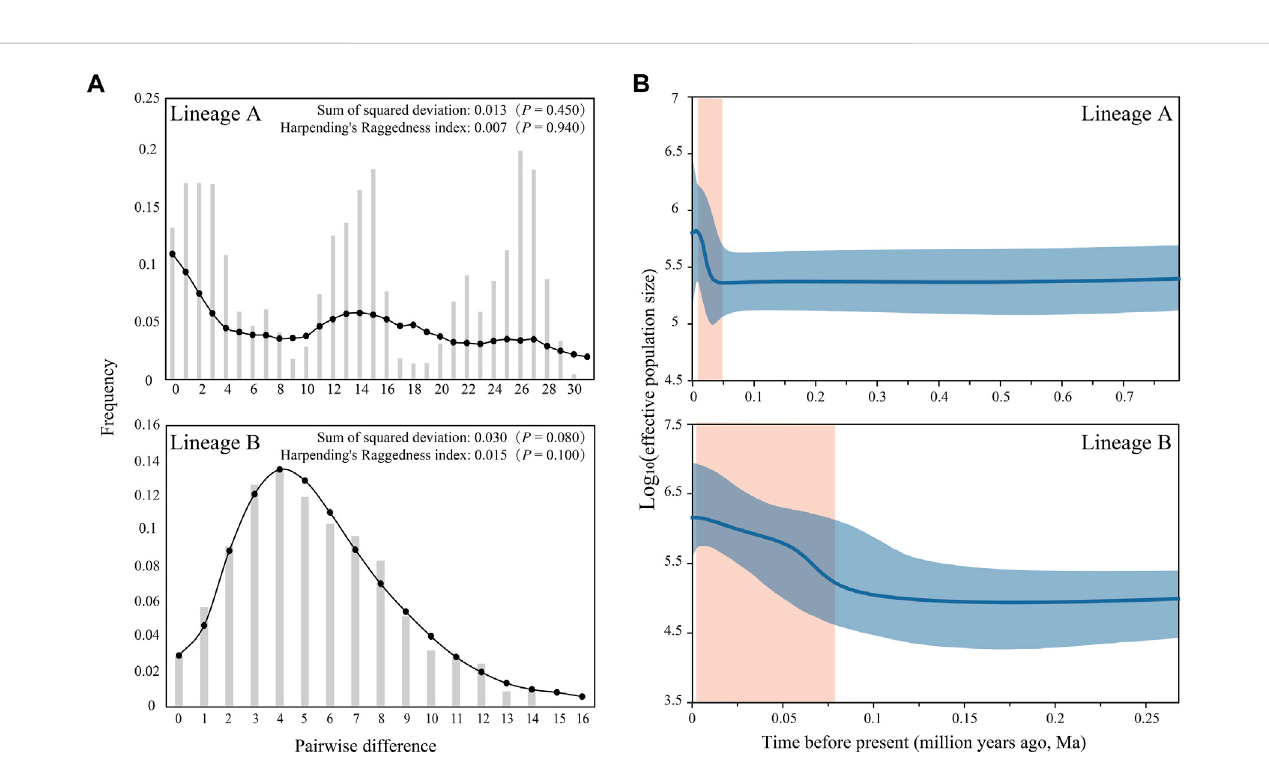
FIGURE 4 PopulationhistoricdynamicsforlineagesAandBof S.parvus : (A) Mismatchdistribution;thebarandlinewithpointrepresenttheobservedandpredictive distributions, respectively. (B) Bayesian skyline plot; the blue line and shadow represent the median and 95% CI of effective population size, respectively, and the orange shadow represents the time frame of demographic